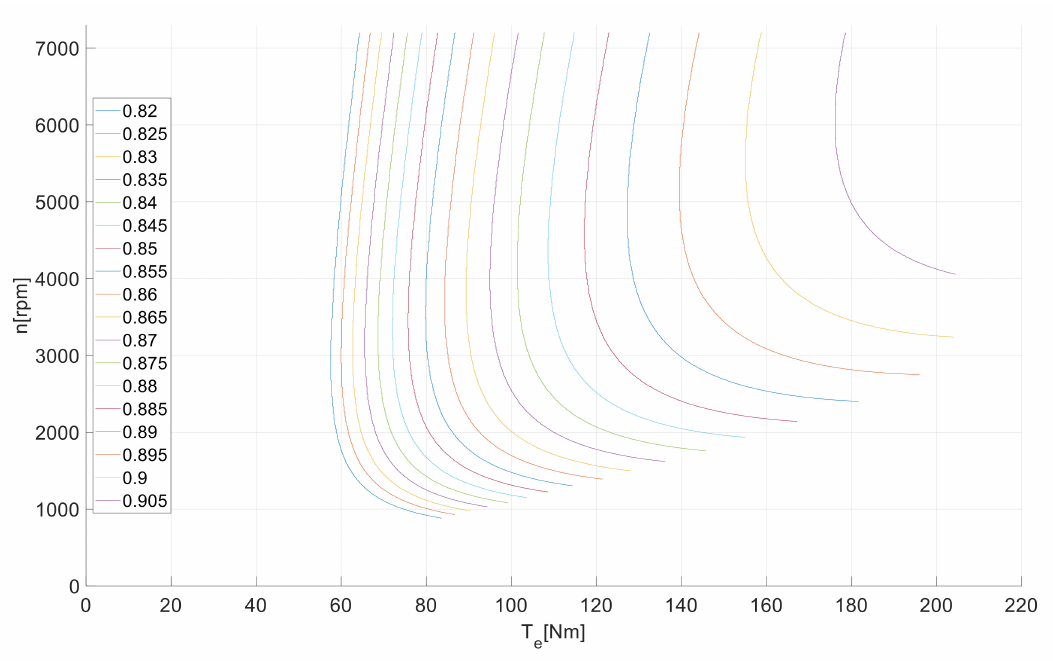
Figure 5. Isocurves of the system efficiency in the whole rated operating